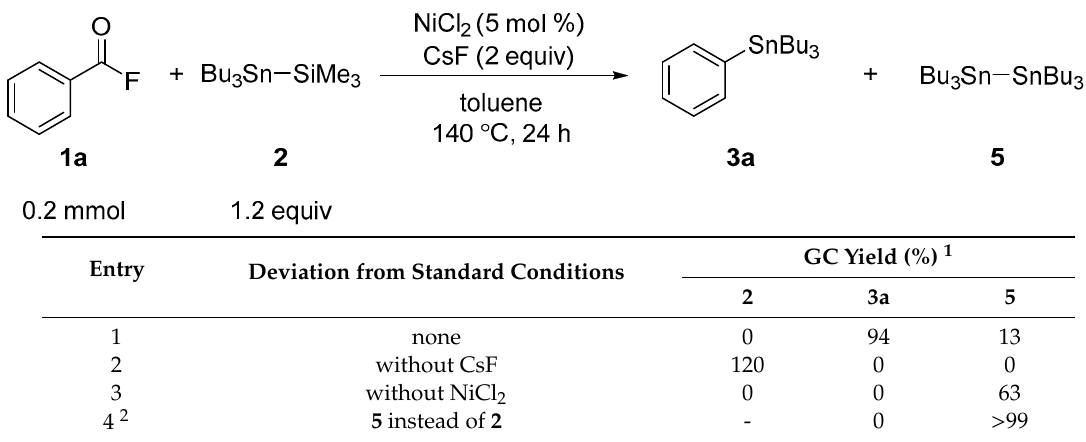
Table 3. Control experiments for Ni-catalyzed decarbonylative stannylation.